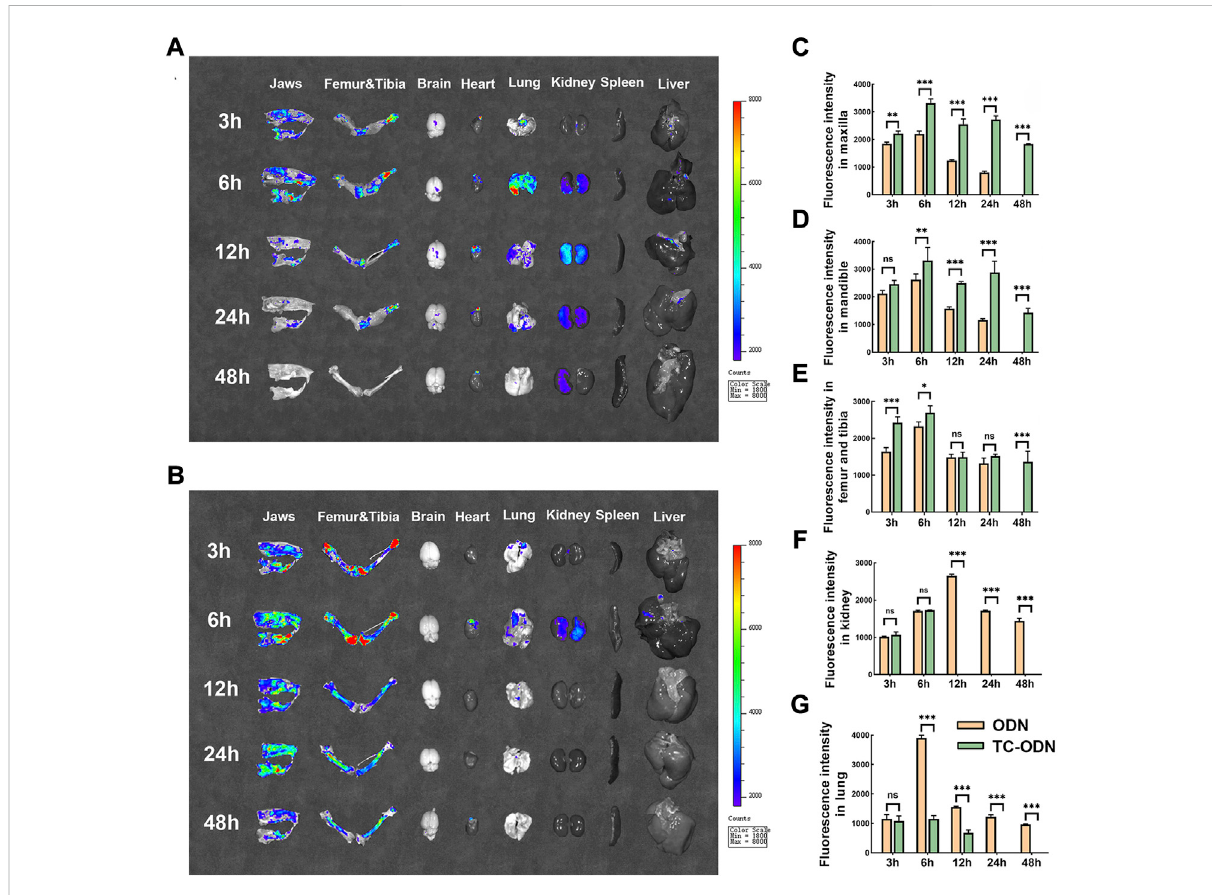
FIGURE 4 The bone-targeted capacity of TC-ODN in vivo. (A) Representative images of tissue distribution of odanacatib-FITC at each time point. (B) Representative images of tissue distribution of TC-ODN-FITC at each time point. (C – G) The fl uorescence intensity of odanacatib and TC-ODN in maxilla, mandible, femurand tibia, kidney, and lung,respectively ( n = 3).Data arepresented as means ± SD.* p < 0.05, ** p < 0.01 and *** p < 0.001 by one-way